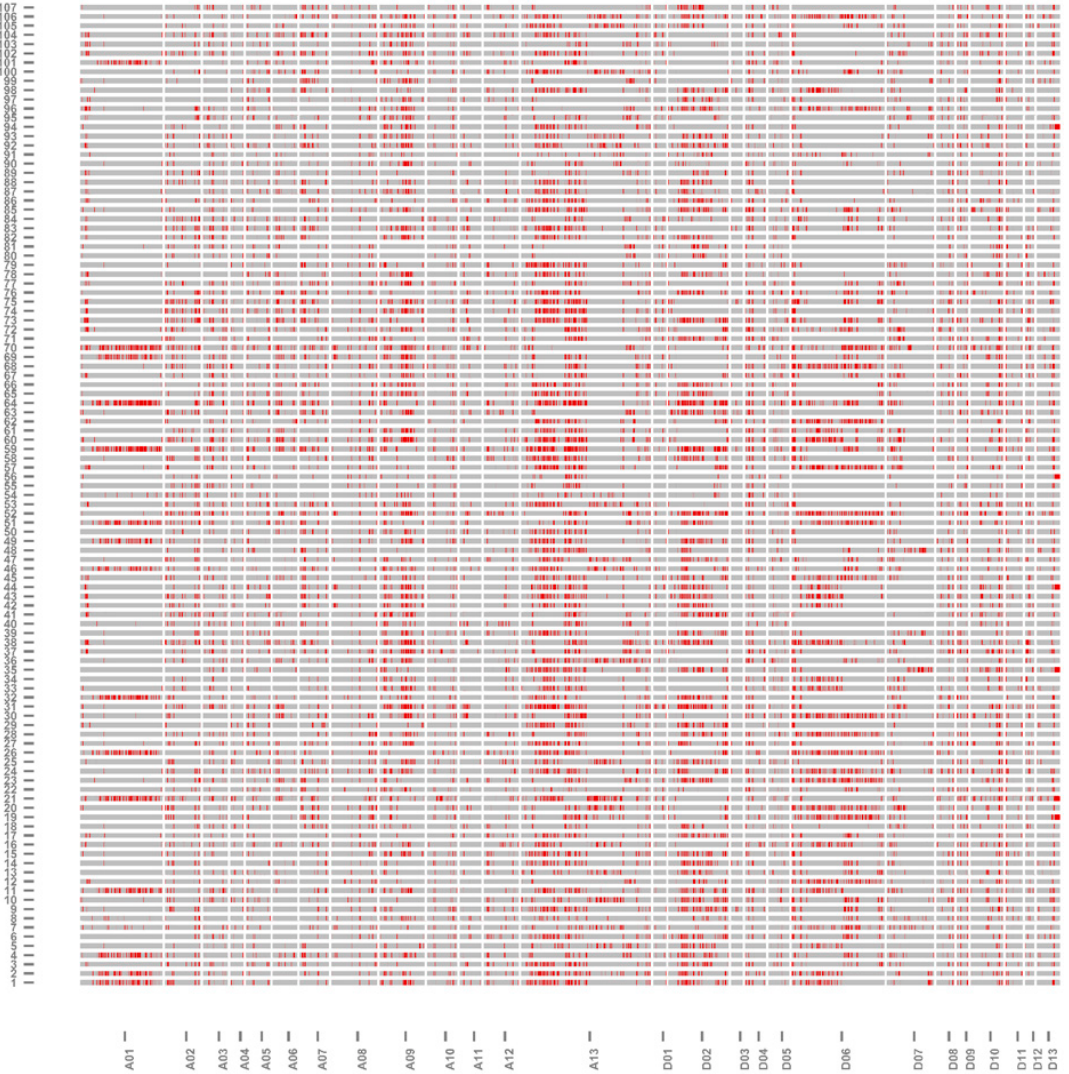
Figure 4. Graphic of genotypes of the 107 ILs. Red regions represent introgression segments from G. tomentosum.